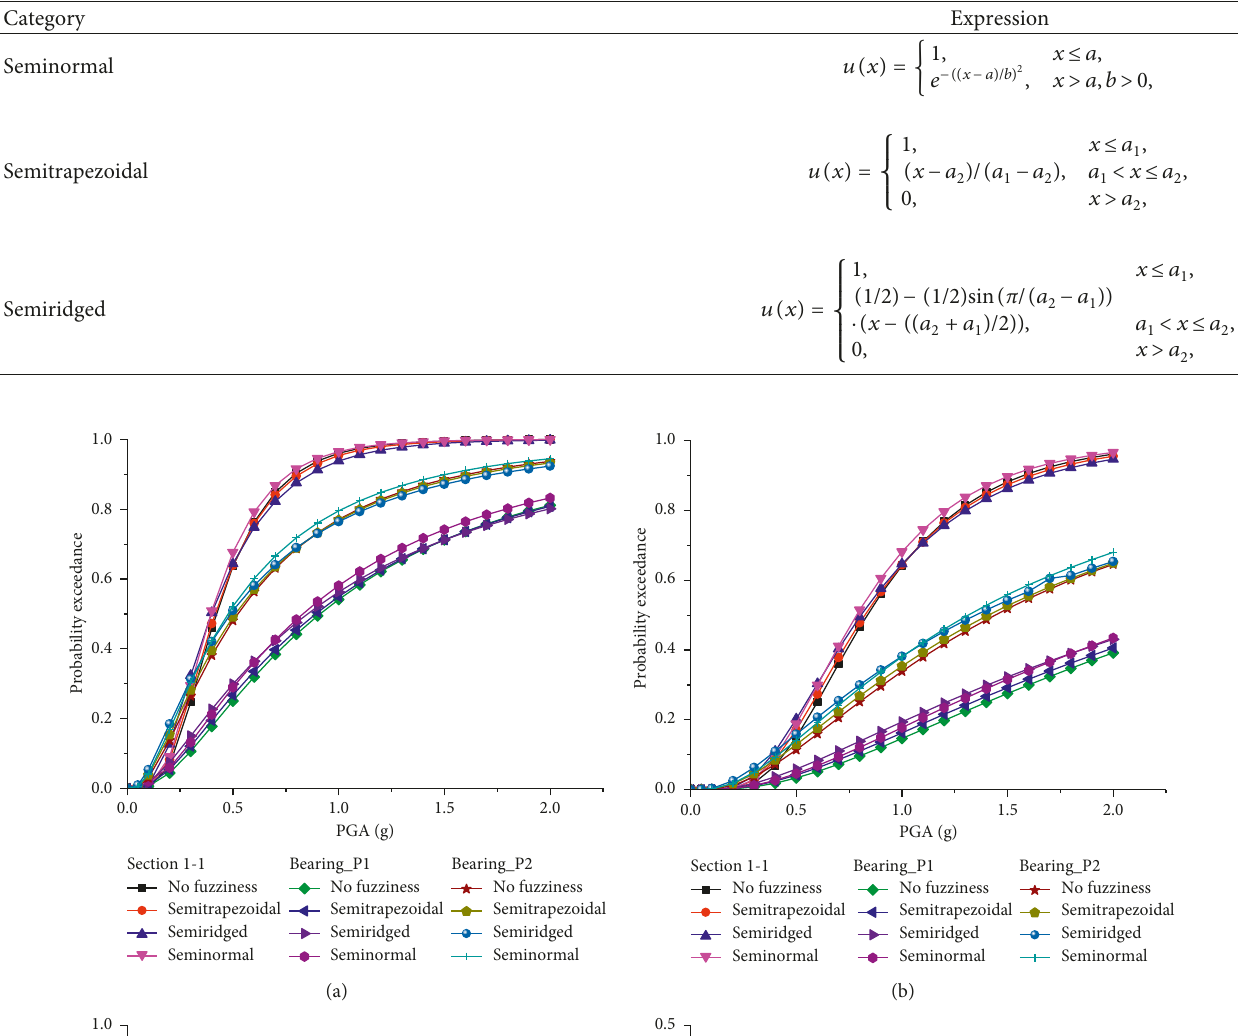
Table 6: Deflection minor membership function.